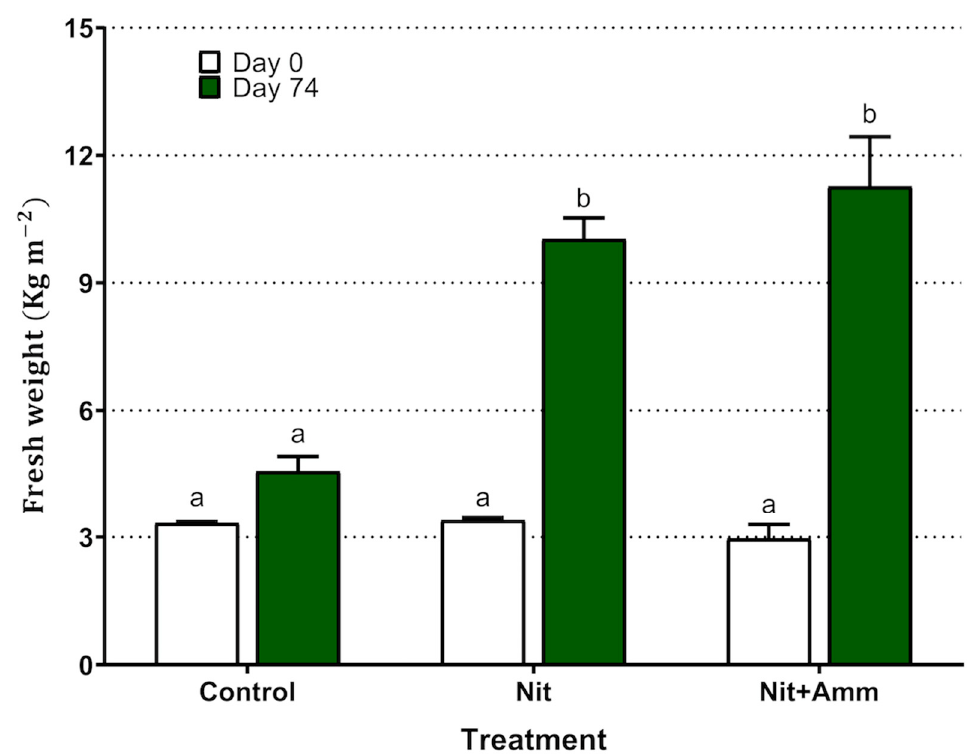
Figure 2. Production of biomass of Salicornia neei by treatment expressed as yield of fresh weight per area unit (kg m − 2 ). Nit + Amm: corresponds to the treatments irrigated with nitrate-N and ammonium-N, Nit: irrigated with nitrate-N, Control: treatment irrigated with sea water only. Lower-case letters represent significant differences between treatments. Mean values of three lysimeters per treatment are displayed (±EE).